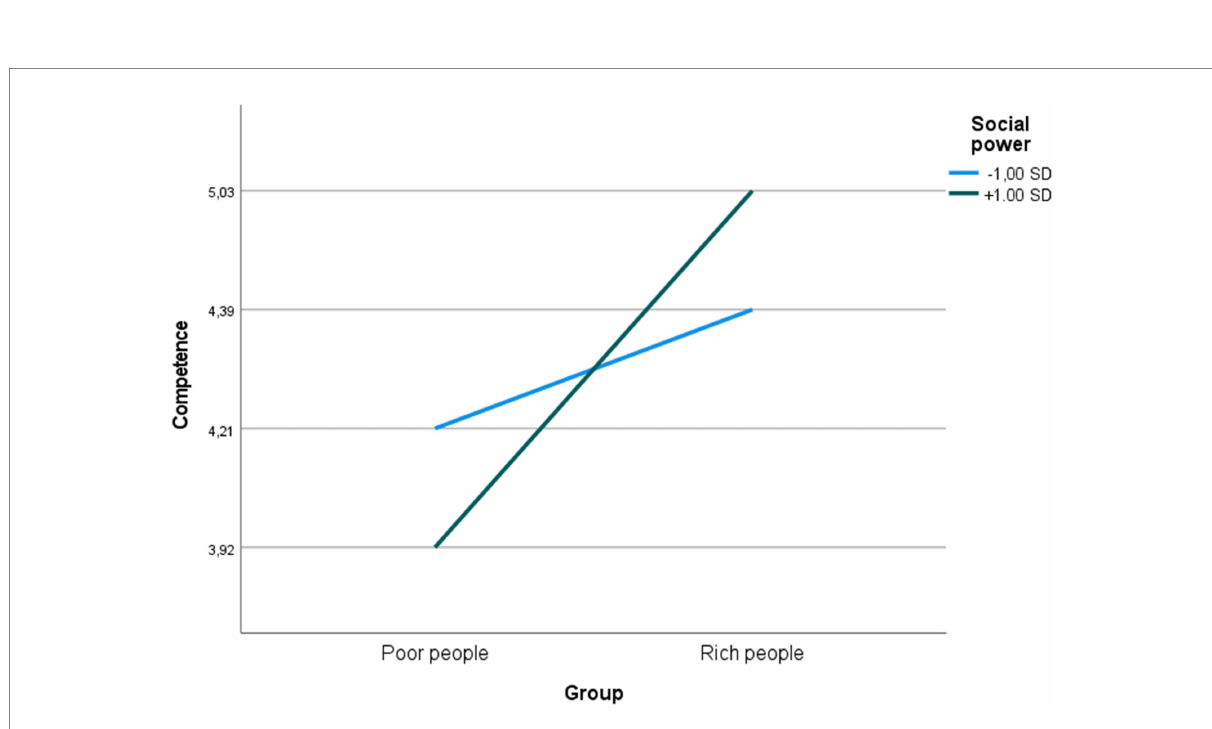
FIGURE 2 Predicted perceptions of competence at high and low levels of social